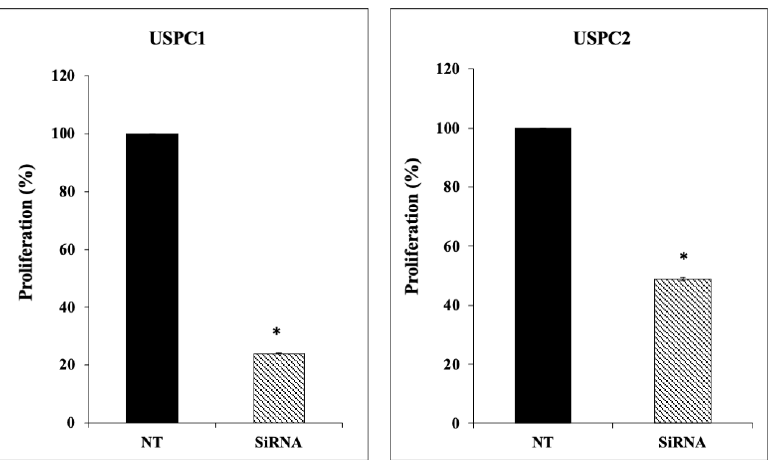
Figure 7. Effect of OR5H2 knockdown on cell proliferation. USPC1 and USPC2 cells (1 × 10 4 cells/well) were plated on 6-cm plates in serum-containing media and, after 24 h, OR5H2 gene expression was abolished as described in Materials and Methods . Cell proliferation was measured after 72 h (USPC1) or 48 h (USPC2) using a Cellometer cell counter. Results of a representative experiment repeated three times with similar results are shown. *, p < 0.01 versus respective con- trol.